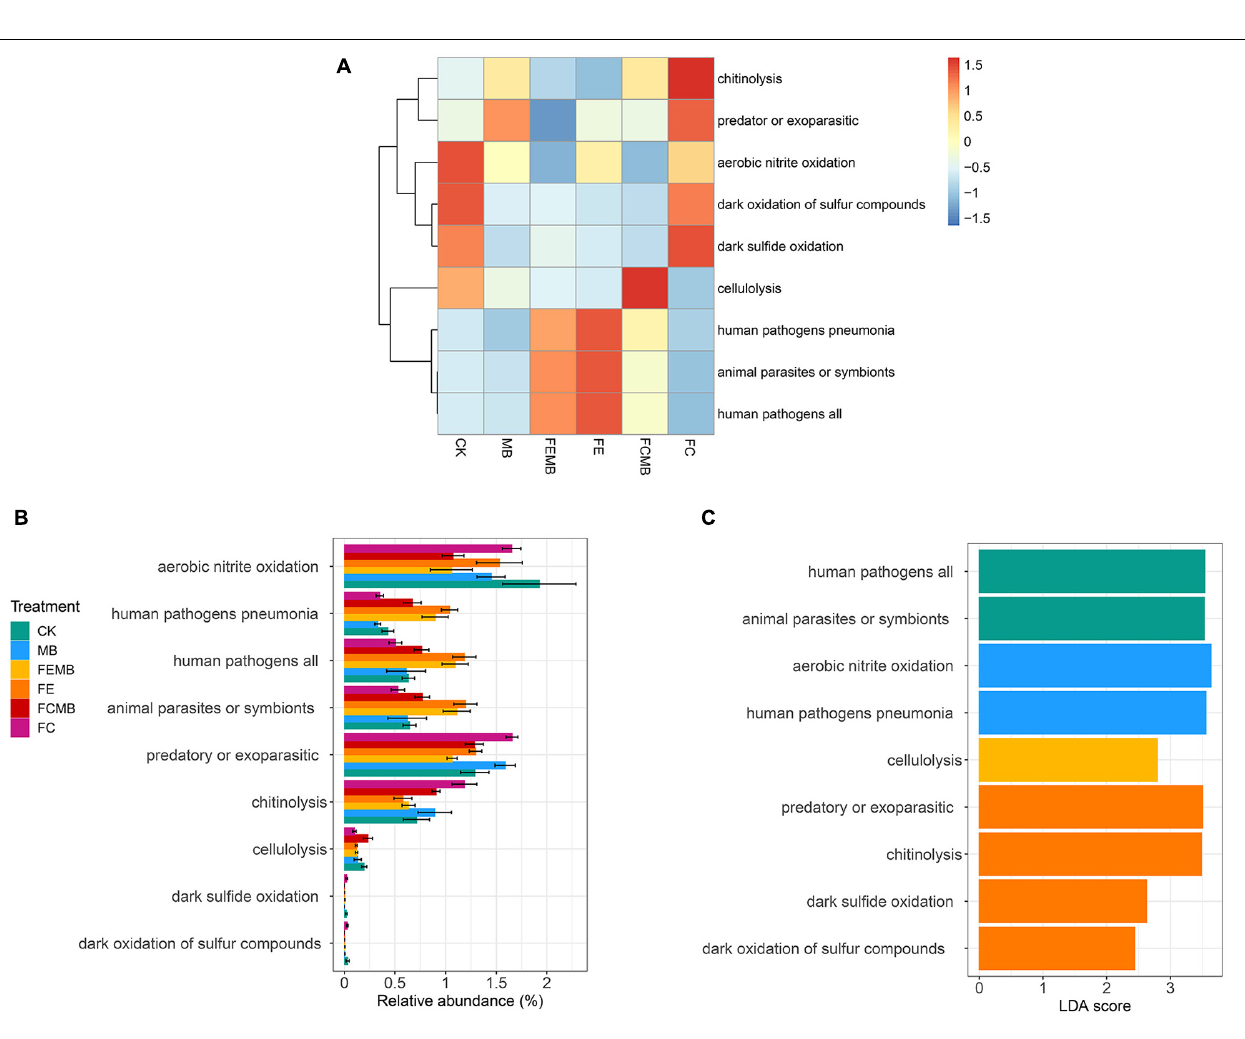
This indicated that the microbial agent survived in the